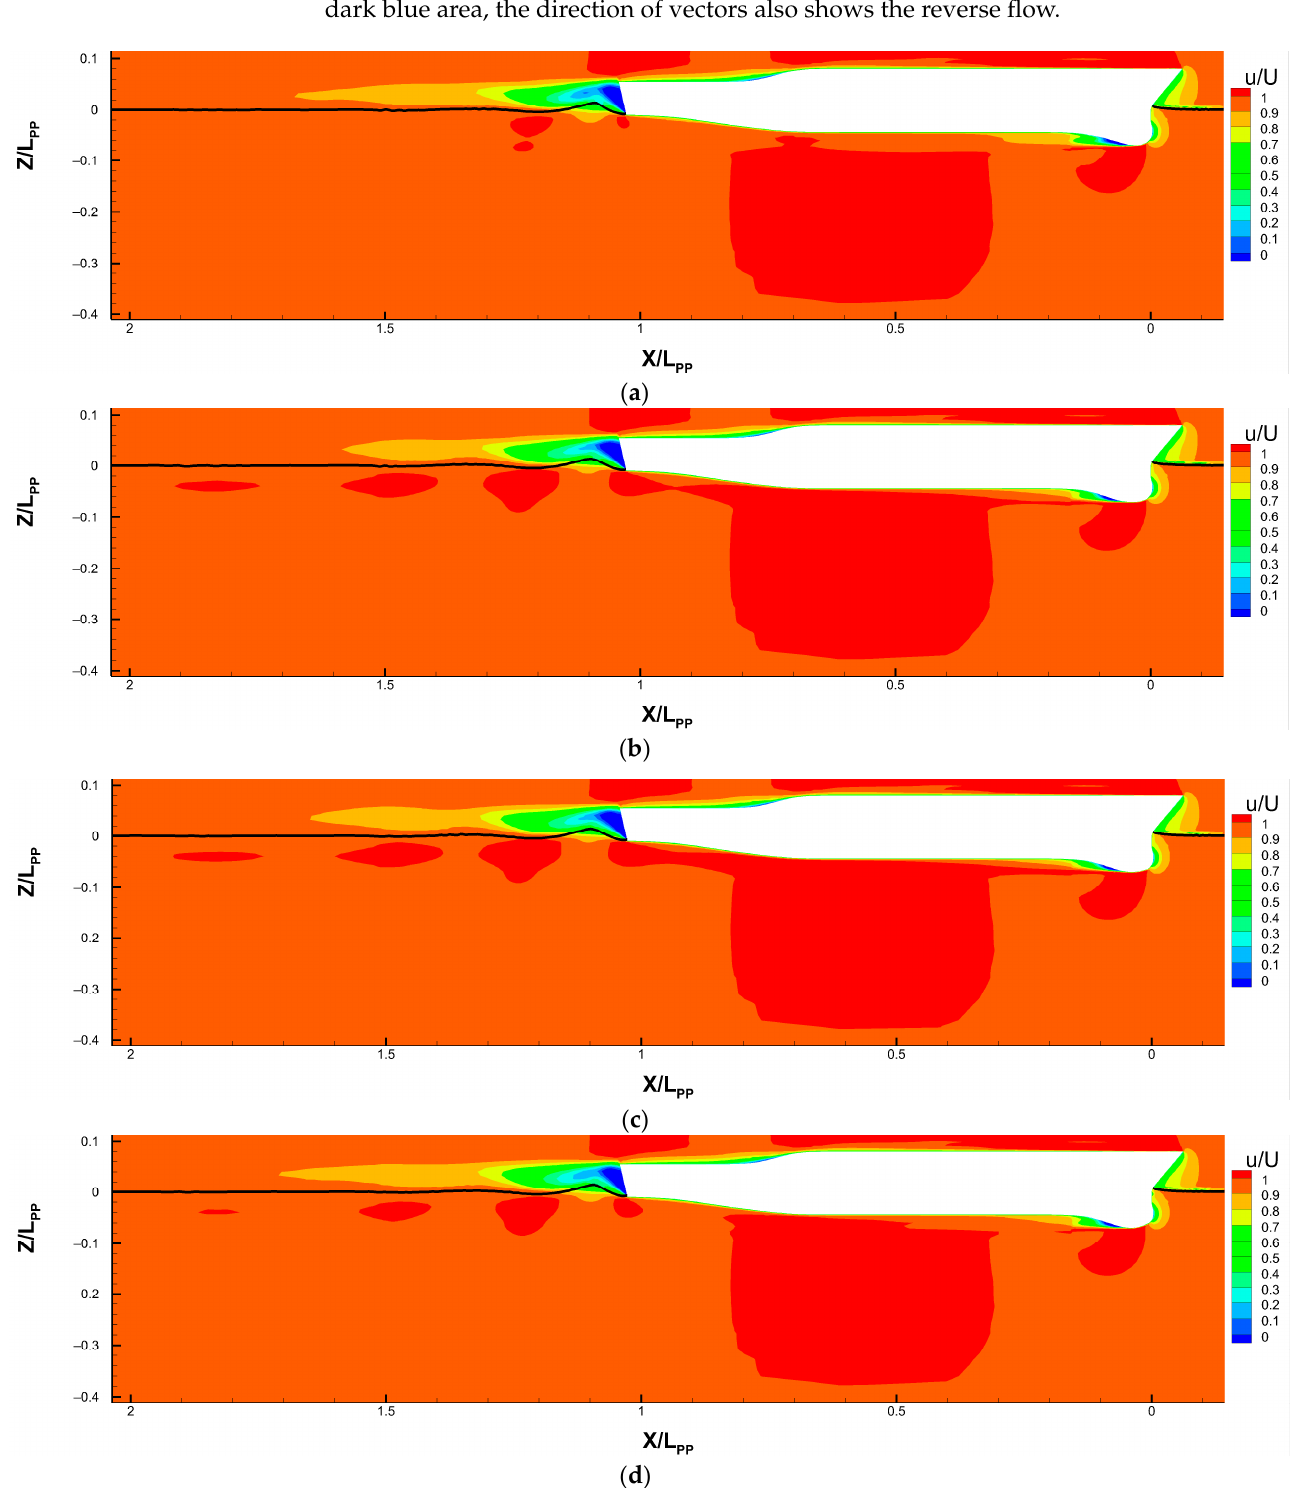
Figure 10. Axial velocity distribution around the ship hull (on Y = 0 plane). ( a ) Original sonar dome, ( b ) A17.830, ( c ) B17.018 and ( d ) B17.018v. The black line represents water